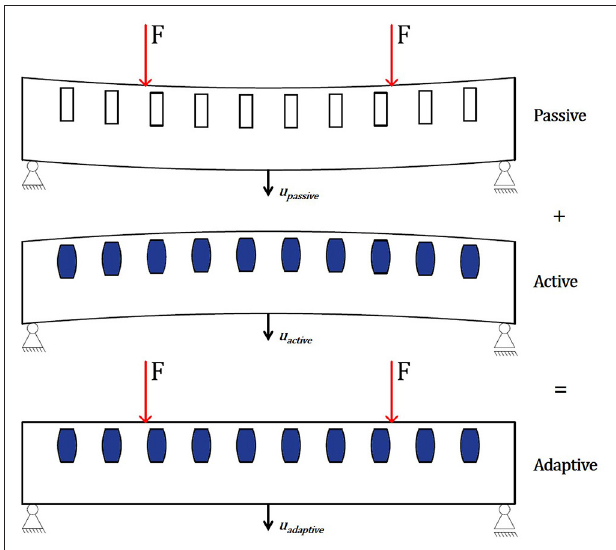
FIGURE 1 | Concept of adaptive beams with integrated actuators. Passive state (Top) ; active state (Middle) ; and adaptive state (Bottom)